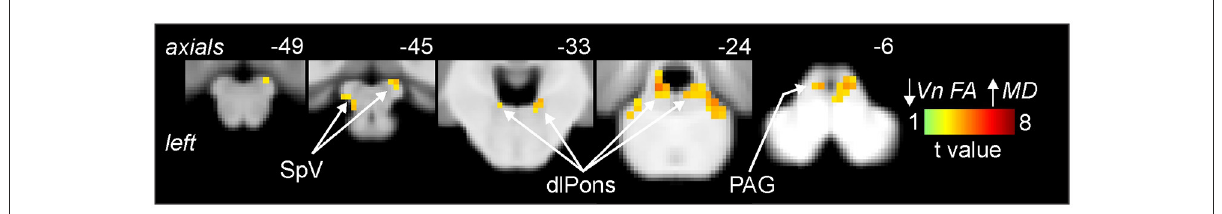
FIGURE2 Areas of the brainstem in which reductions in trigeminal nerve fractional anisotropy (FA) were significantly correlated with increases in brainstem mean diffusivity (MD) assessed in migraine ( n = 32) and control participants ( n = 31). Significant clusters are overlaid onto a mean T1-weighted brainstem template image. Slice locations in Montreal Neurological Institute (MNI) space are indicated to the top right of each slice. Note that MD was significantly correlated to nerve FA in the brainstem regions of the spinal trigeminal nucleus (SpV), dorsolateral pons (dlPons) and the periaqueductal gray matter